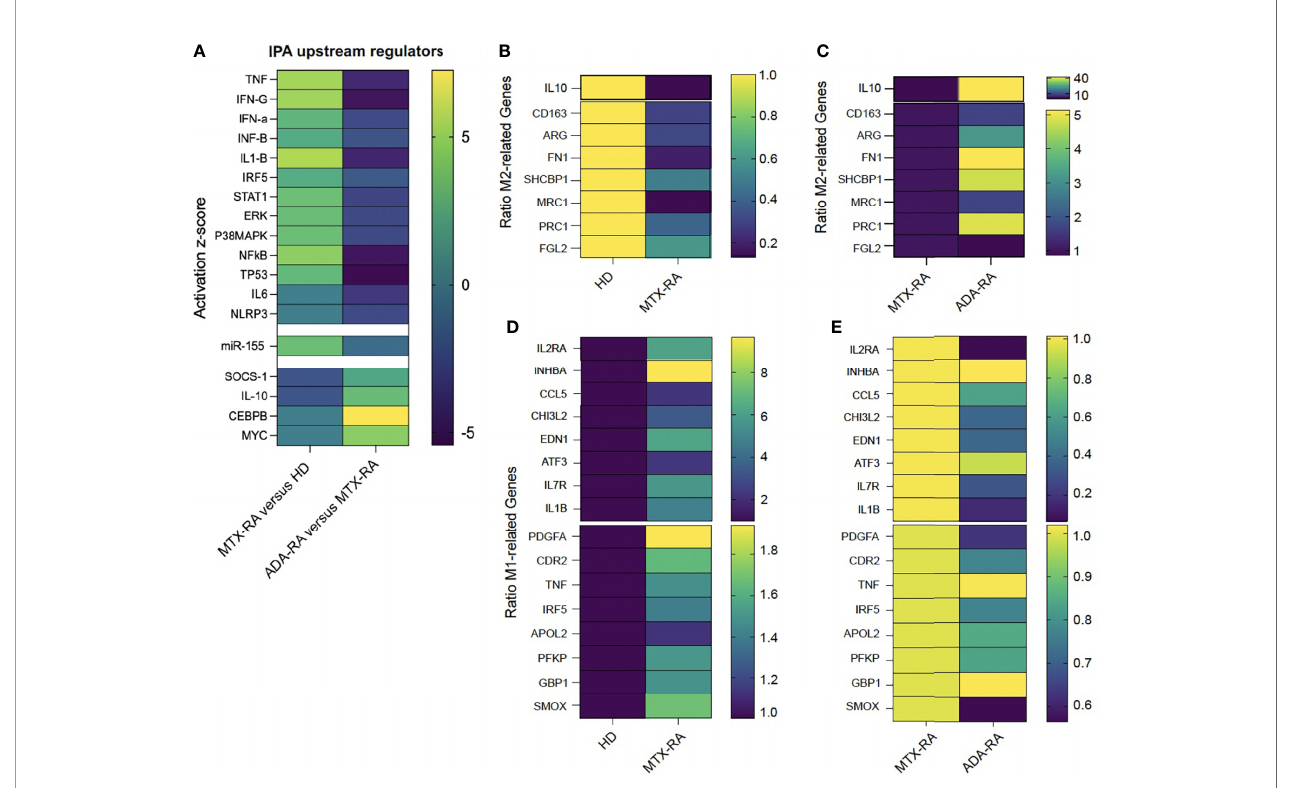
FIGURE 4 | The defect in M2-like polarization leads to an M1-like macrophage phenotype. Heatmap of a predicted upstream regulator effect on M2-like macrophages after monocyte polarization with serum AB (SAB) differentiation in rheumatoid arthritis-methotrexate (RA-MTX) patients versus healthy donors (HDs) or RA-adalimumab (RA-ADA) versus RA-MTX patients. The color of each square represents the activation z-score: activated = yellow (+5), inhibited = dark blue ( − 5) (A) . Heatmap of the ratio of the normalized count of M2-related genes in RA-MTX patients versus HDs (HD = 1 yellow) (B) or RA-ADA patients versus RA-MTX patients (RA = 1 dark blue) (C) . Ratio of normalized counts of M1-related genes in RA patients versus HDs (HD = 1 dark blue) (D) or RA-ADA patients versus RA patients (RA = 1 yellow) (E) . MRC-1 gene = CD206